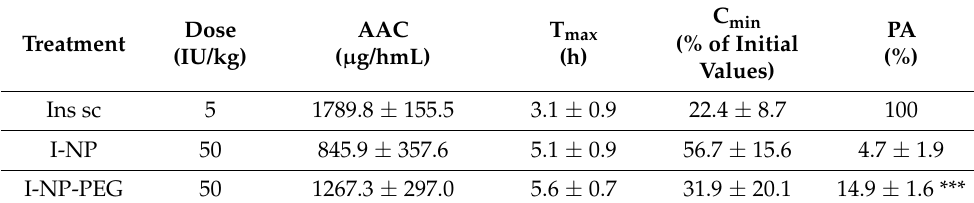
Table 2. Main pharmacodynamic parameters after a subcutaneous administration of insulin (5 IU/kg) or after oral administration of bare nanoparticles loaded with insulin (I-NP; 50 IU/kg) or PEG-coated nanoparticles loaded with insulin (I-NP-PEG; 50 IU/kg). AAC corresponds to the area above the glycemic curve; T max corresponds to the time when the maximum effect was achieved; C min corresponds to the minimum levels of glucose (as a % of the initial values) were achieved; PA corresponds to the pharmacological activity. Data represent the mean ± SD ( n ≥ 6). ***: p < 0.001, compared to I-NP.